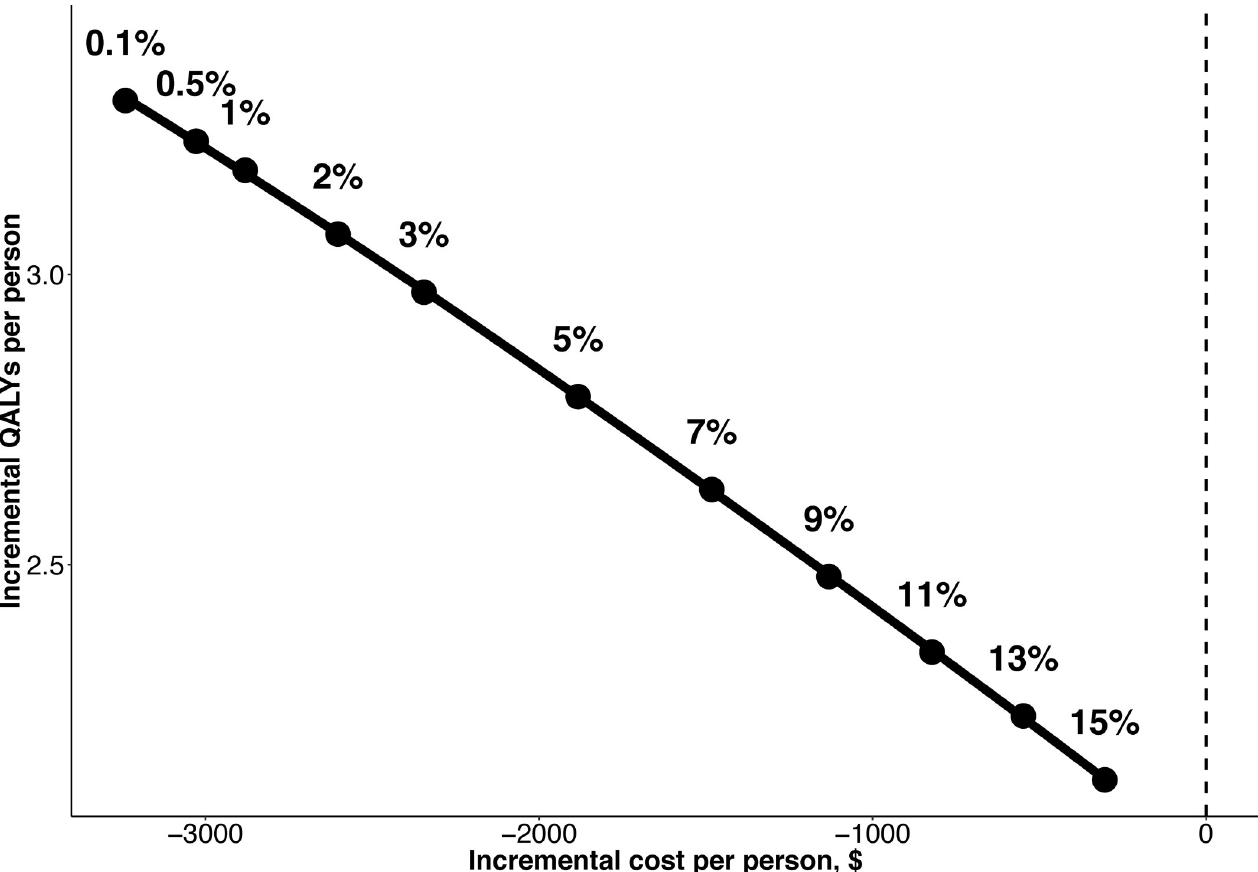
Fig 1. Incremental costs (horizontal axis) and QALYs (vertical axis) for treating F2-F4 fibrosis with DAAs in India compared to no treatment for various reinfection rates.